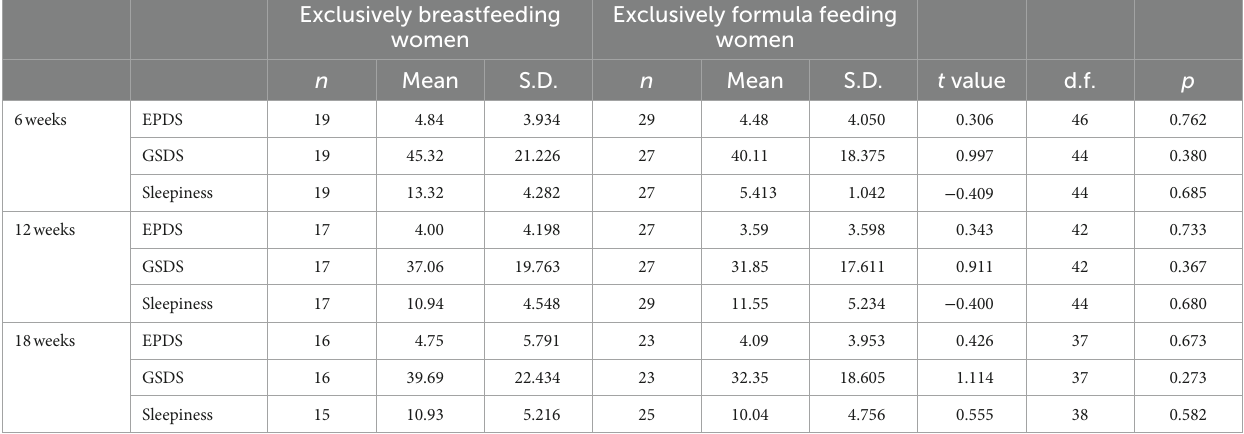
TABLE 6 T -test comparisons of EPDS, GSDS and sleepiness score for exclusively breastfeeding and exclusively formula feeding